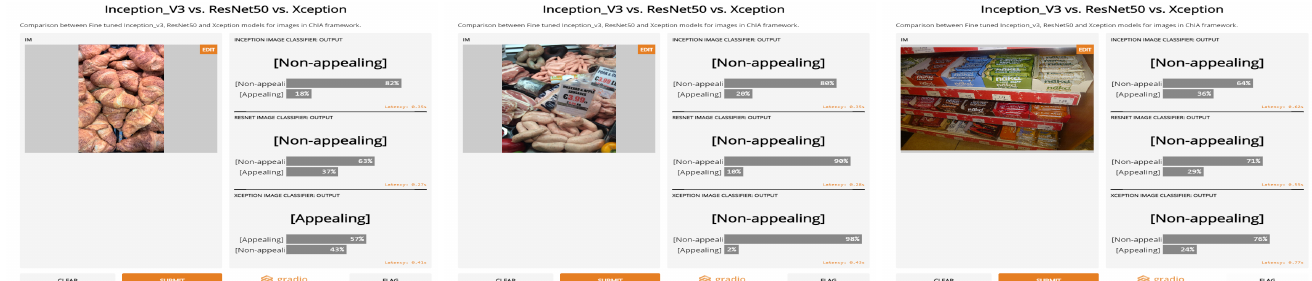
Figure 3. Sample images and their predicted categories using the three models. The images are cultural food images that are taken from the Europeana platform. The predictions of the three models indicate the categories (Appealing/Non-appealing) of the images along with the confidence score of each